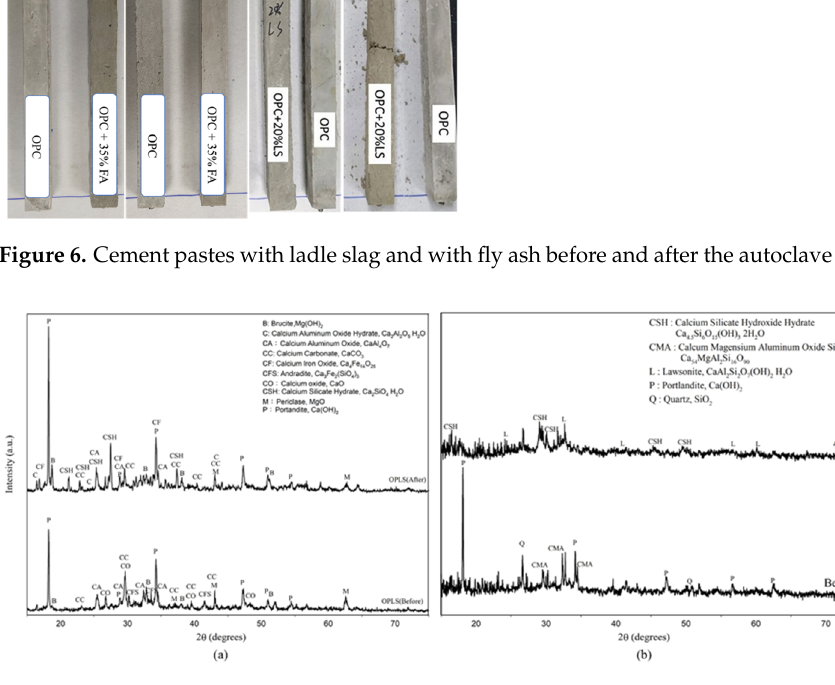
Figure 7. XRD patterns of cement paste with ( a ) ladle slag and ( b ) fly ash before and after the autoclave expansion test. Table 5. Ca(OH) 2 content (%) before and after autoclaving related to volume stability with ladle slag and fly